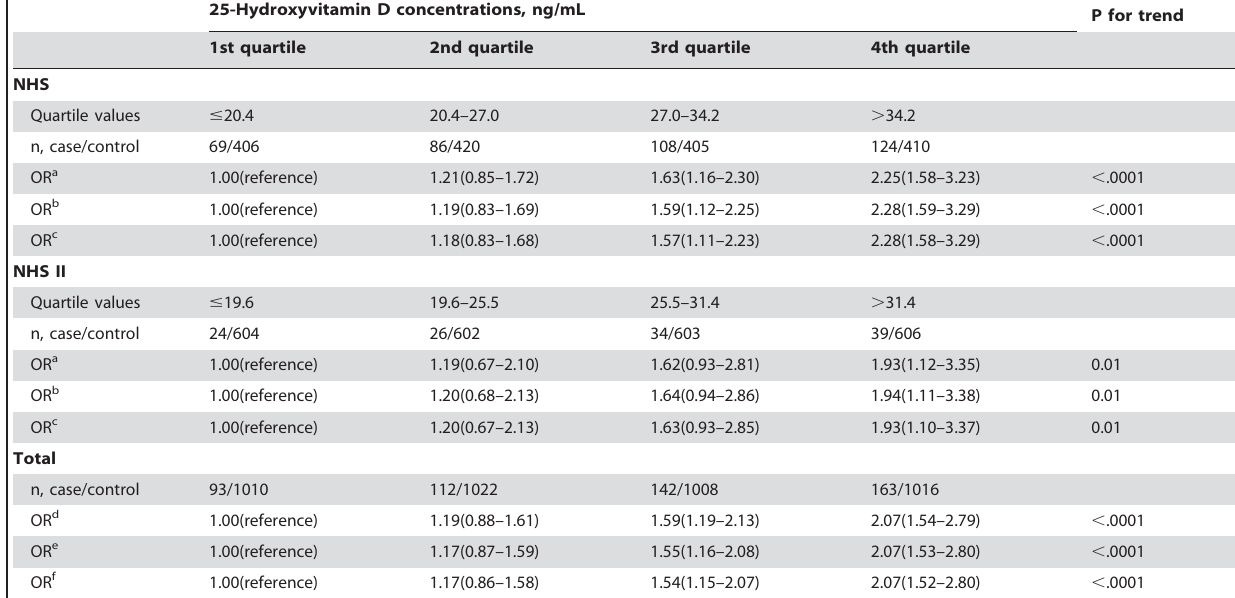
Table 2. Odds ratios of BCC by quartile of plasma vitamin D concentrations in NHS and NHS